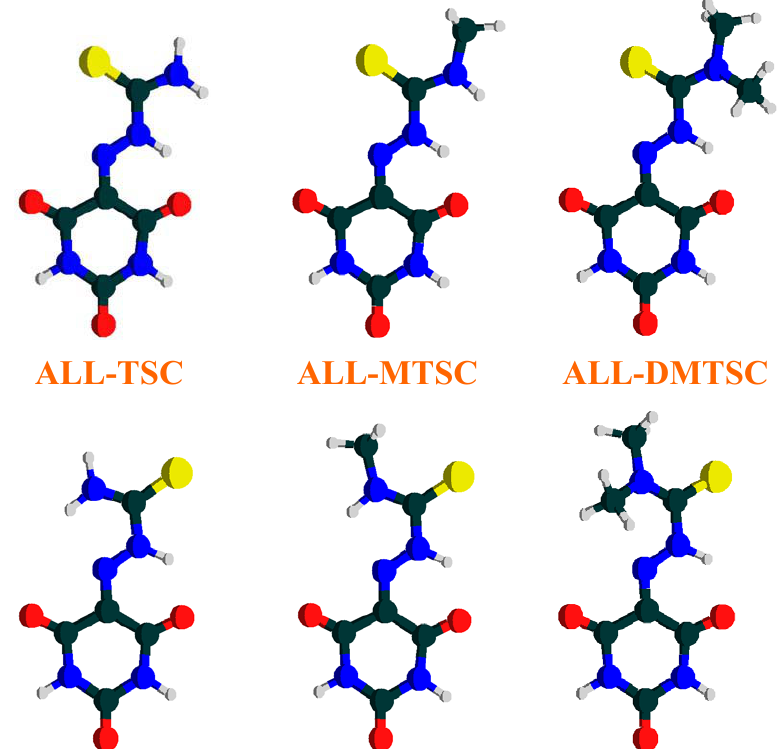
Fig. 5 Optimized structures of alloxan-based thiosemicarbazones.